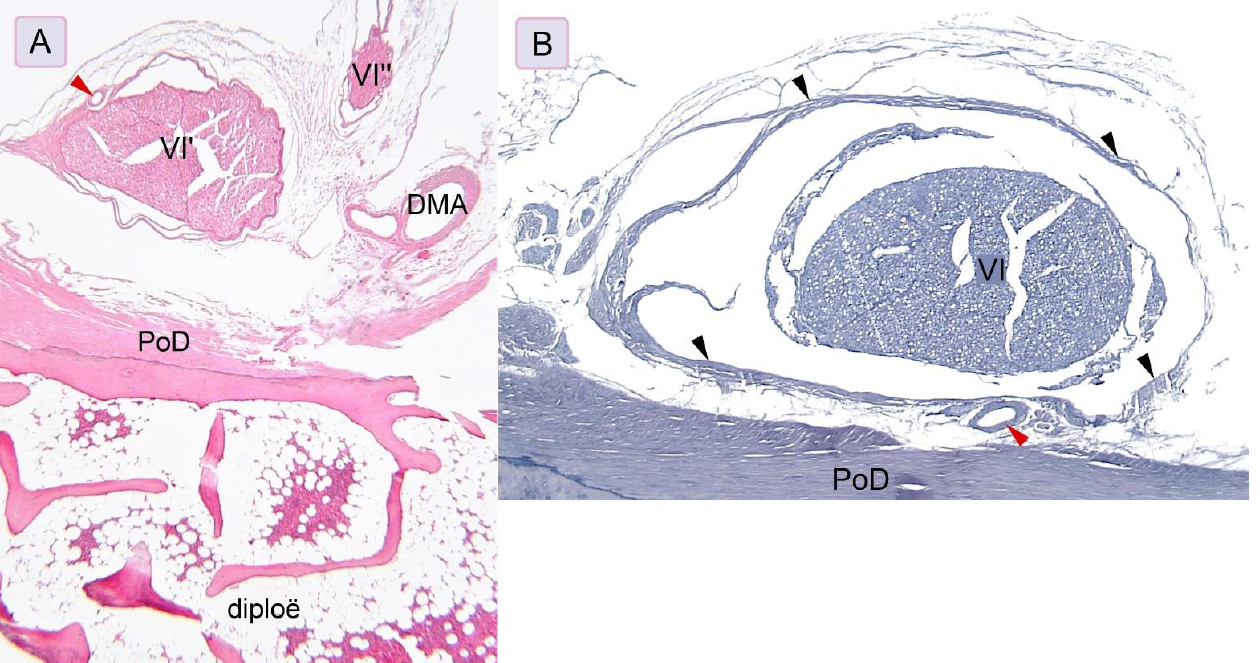
Figure 6. The relationship between the dural sleeve of the gulfar segment of the abducens nerve and the periosteal layer of the dura mater. ( A ) Aberrant fascicle (VI′′) of the abducens nerve (VI′) present at the petrous apex. In this specimen, the dorsal meningeal artery (DMA) is located close to the nerve. In this histological slice, the abducens nerve’s meningeal cuff became detached from the periosteal dura during the histological preparation. Anatomical structures are shown with hematoxylin and eosin staining under a 2× objective lens. ( B ) The abducens nerve’s gulfar segment (VI) is surrounded by the dural sleeve (marked by black arrowheads). The dural covering of the nerve is fixed to the periosteal dura (PoD). Anatomical structures are shown with Hansen’s hematoxylin staining under a 4× objective lens. For both figures, red arrowheads mark small arteries within the dural sleeve.